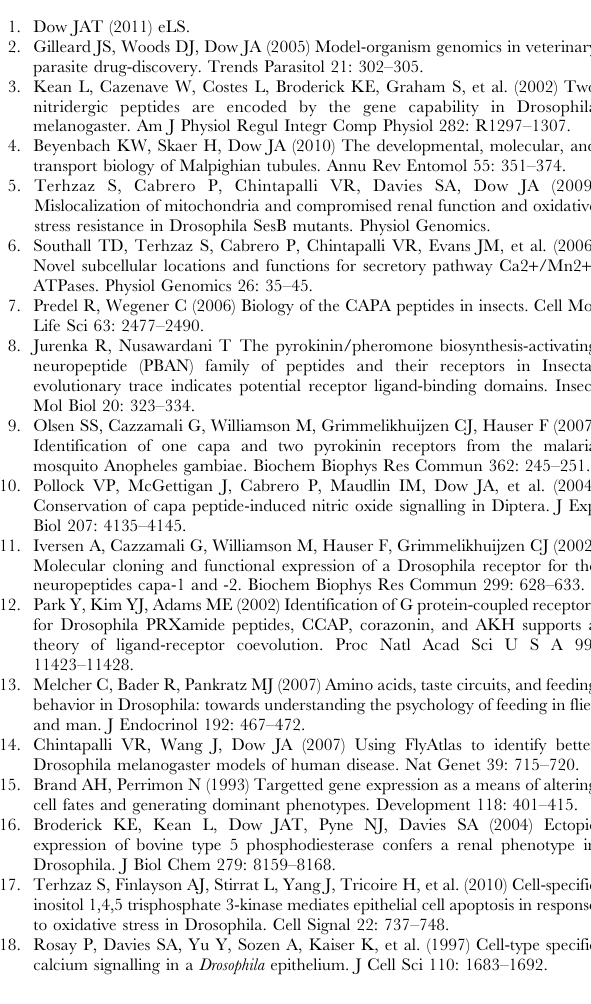
Figure S1 Validation of capaR RNA interference knock- down. ( A ) Q-PCR analysis confirmed a 65% decrease in capaR mRNA levels in the whole fly compared to control flies. Data are expressed as 10 2 5 ng of capaR mRNA 6 SEM, N = 3. Figure S2 Tubule mRNA expression of GRK-1 and GRK- 2 under capa-1 stimulation. Wild-type ( Canton-S ) tubules were excised, incubated in Schneider’s medium for 3 h as controls, or treated with 10 2 7 M (final concentration) of capa-1 in Schneider’s for 3 h. Samples were prepared for Q-PCR to assess GRK-1 or GRK-2 expression levels in control and capa-1-treated tubules (shaded bars). Data were normalized against the rp49 standard, and expressed as ng GRK-1 or GRK-2 mRNA 6 SEM, N = 3.